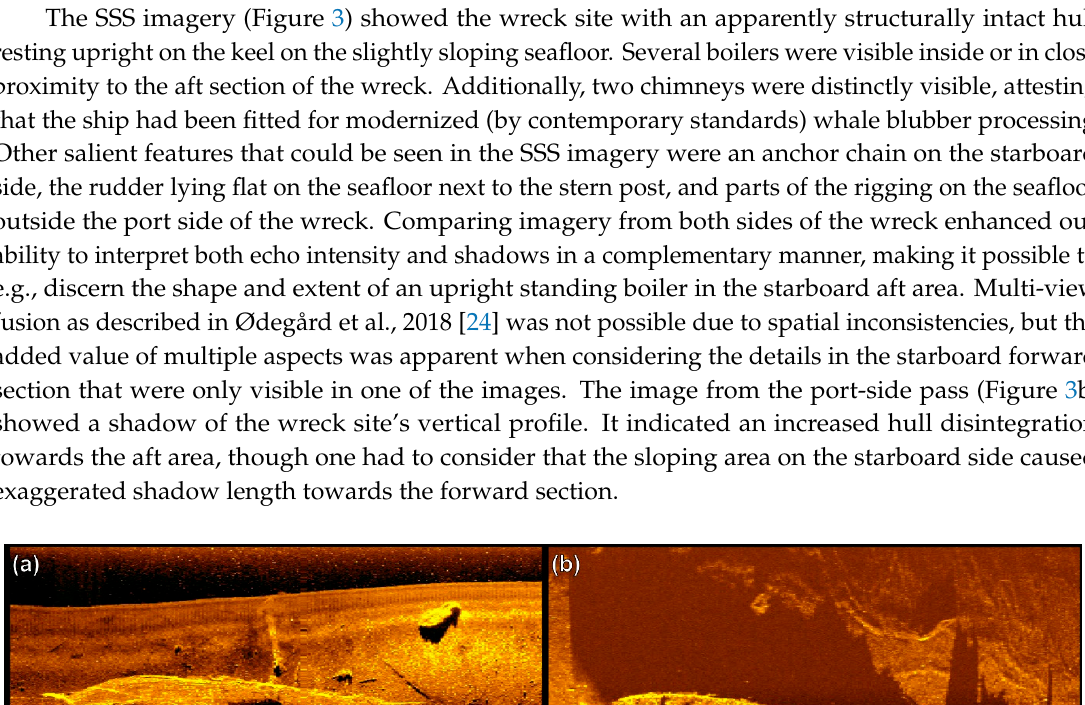
Figure 4. Screenshots from the 2015 mini-remotely operated vehicle (ROV) high-definition (HD) video. Panel ( a ) shows a part of a wooden beam with a brass bolt protruding, and panel ( b ) shows a close-up of exposed wood with signs of gribble attack. The inside of the hull was covered with what appeared to be a thick layer of dead barnacles (crustaceans in the infraclass Cirripedia) and other calcareous shell remains mixed with fine-grained sediment, suggesting relatively high levels of biological activity on the wreck site. A number of well- preserved wooden barrels arranged in rows (indicating they were located in the cargo hold) showed no evidence of gribble or other wood-boring organisms (Figure 5). Steam boilers, cooking vats, and other metal objects were all largely covered with barnacles. Spectrally conspicuous red coralline algae (Rhodophyta) also made considerable contributions to the observed biofouling community. An exception was the copper sheathing and brass bolts extruding from timbers, which showed little or no signs of biofouling or growth. The latter is consistent with copper being a well-known biofouling deterrent [25]. Figure 5. Screenshots from the 2015 mini-remotely operated vehicle (ROV) high-definition (HD) video. Panel ( a ) shows the remains of two barrels with lids, and panel ( b ) shows a part of a mechanical metal construction (wheel) completely covered with barnacles.